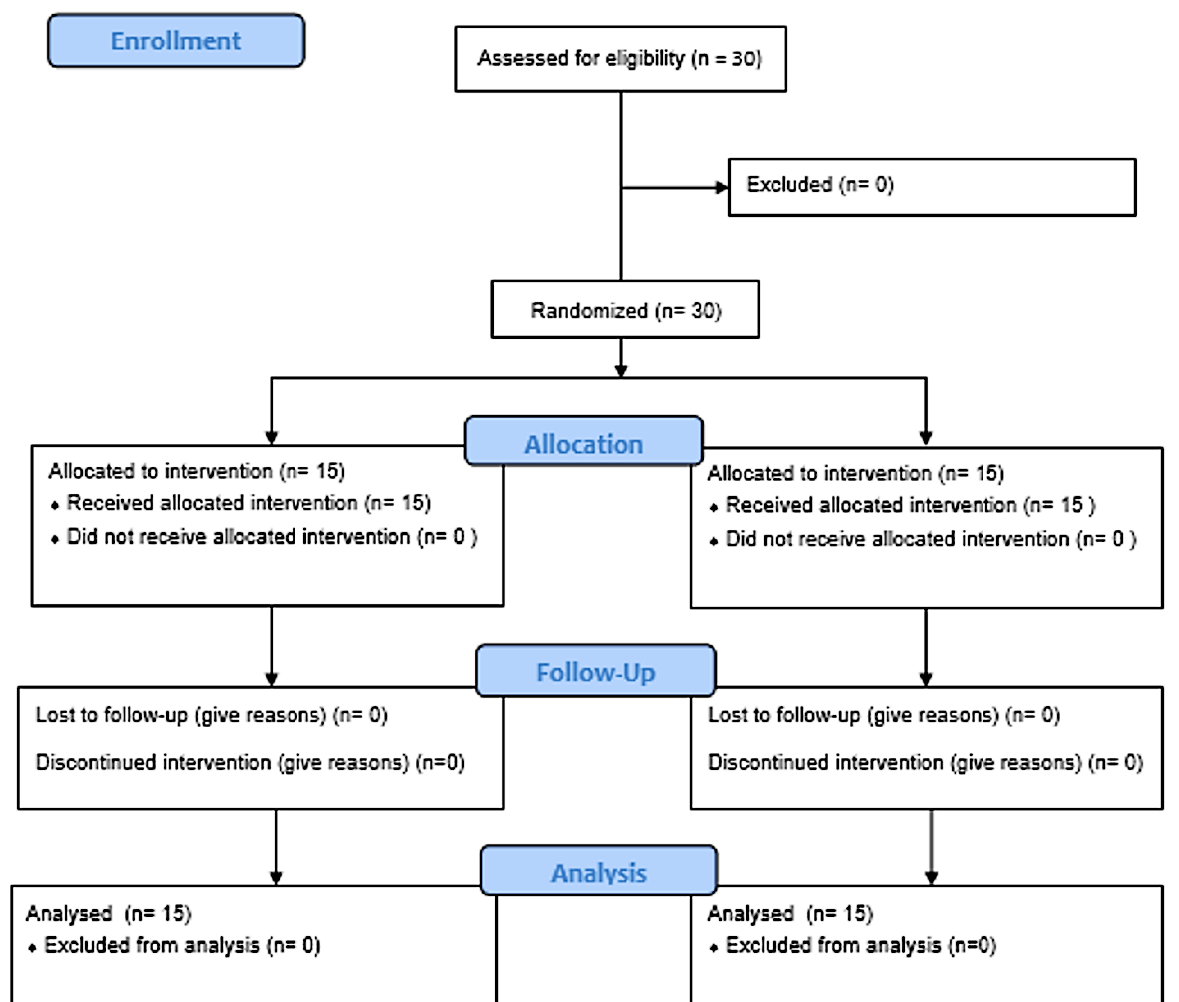
Figure 1. Flowchart of the study.